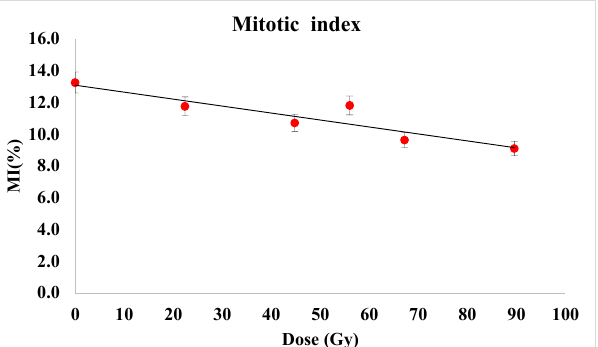
Figure 5. Mitotic index diminution following proton beam exposure. Linear dose-response was evidenced. From 2300 to 3100 analyzed cells from each of five microscope slides corresponding to each variant provided the data used for average value and standard deviation calculation.